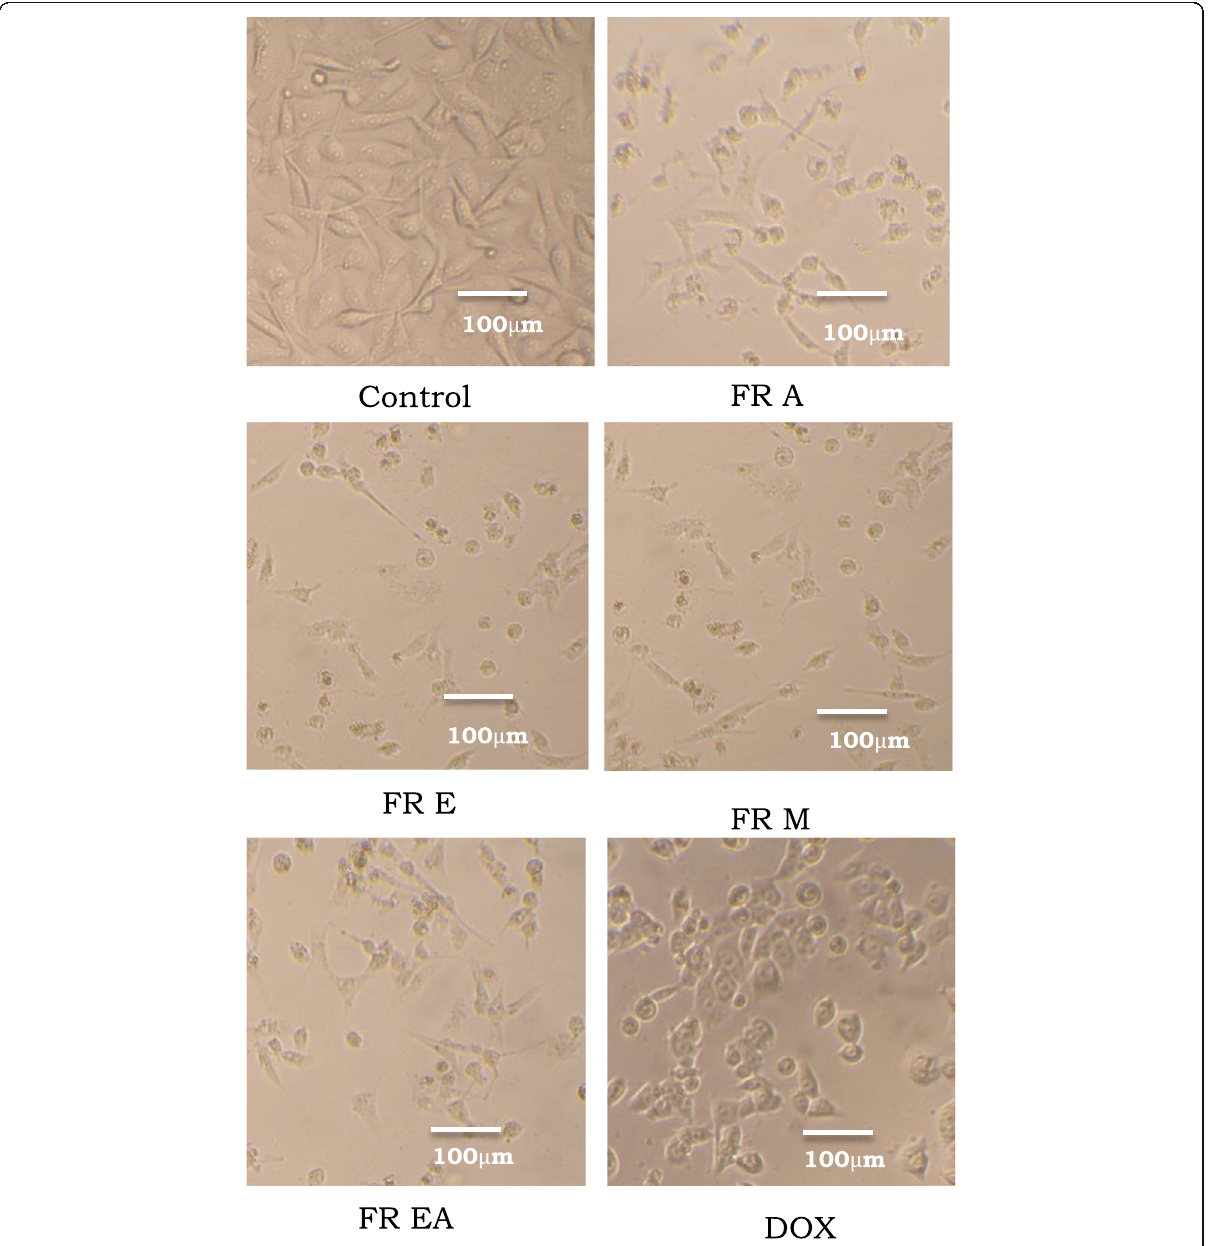
Fig. 1 Morphological changes observed in MDA MB 231 cell line when treated with IC 50 concentrations of F. religiosa latex solvent extracts along with control (MDA MB 231) and doxorubicin (DOX) treated cells. A — acetone (111.86 μ g/ml); E — ethanol (50.86 μ g/ml); M — methanol (145.5 μ g/ ml); EA — ethyl acetate (107.25 μ